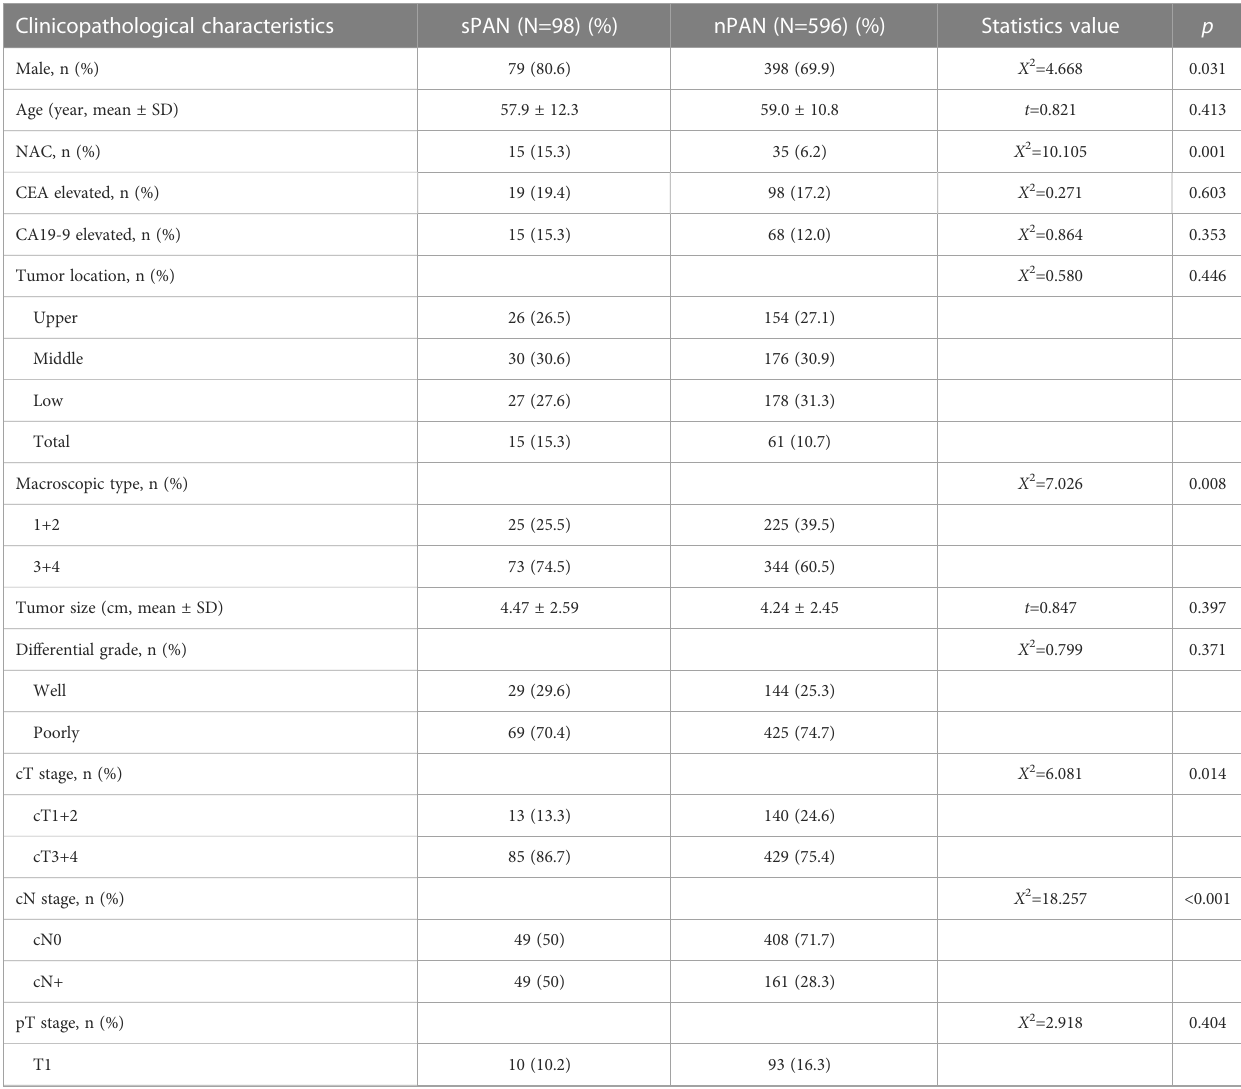
TABLE 1 Clinicopathological characteristics of patients in sPAN and nPAN